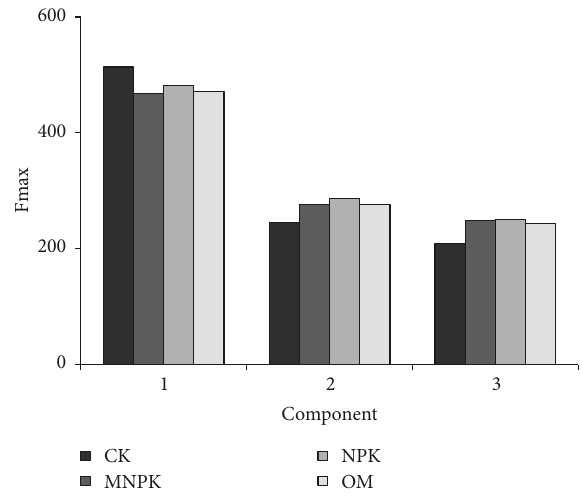
Figure 2: Maximum fluorescence intensity (Fmax) values of PARAFAC components C1, C2, and C3 under different fertiliza- tion treatments (CK=control, NPK= NPK fertilizer, OM=organic manure, and MNPK=manure + NPK).